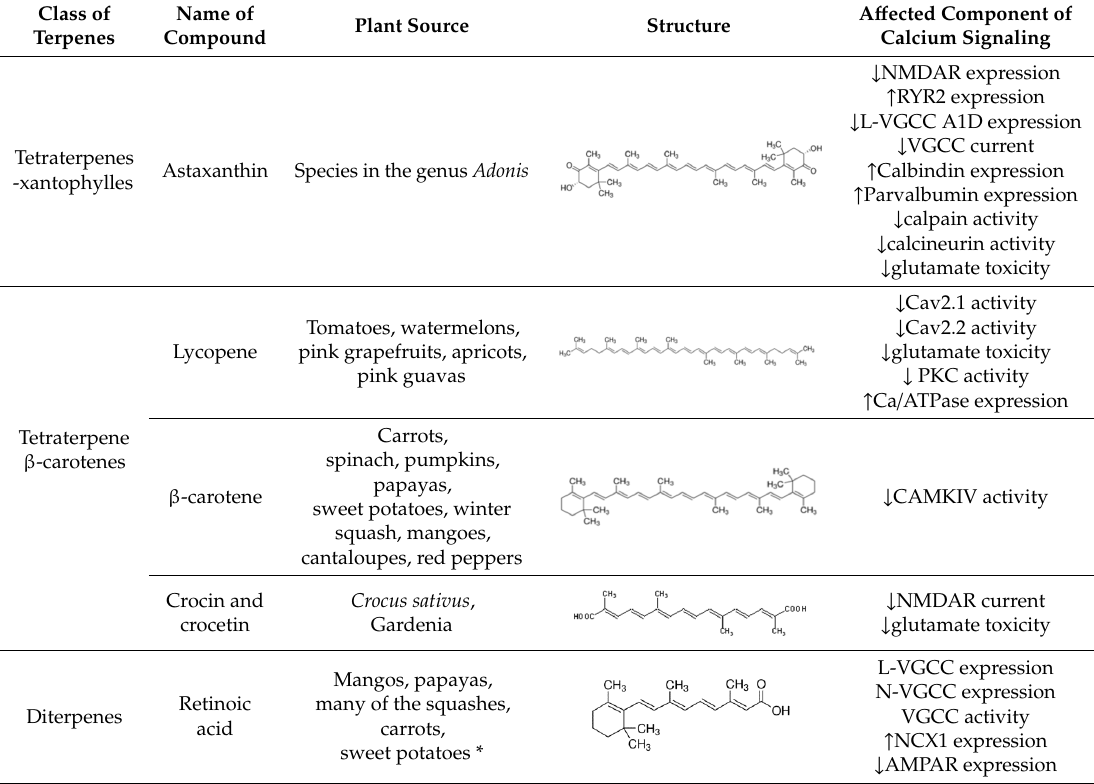
Table 1. Classification, structures, and action of terpenes and terpenoids described in this article.